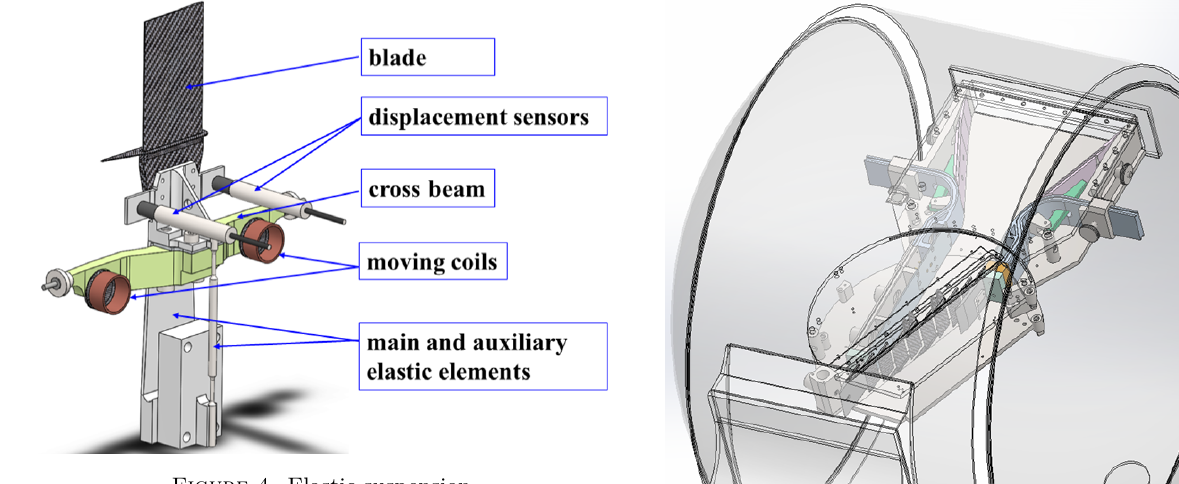
Figure 4. Elastic suspension.